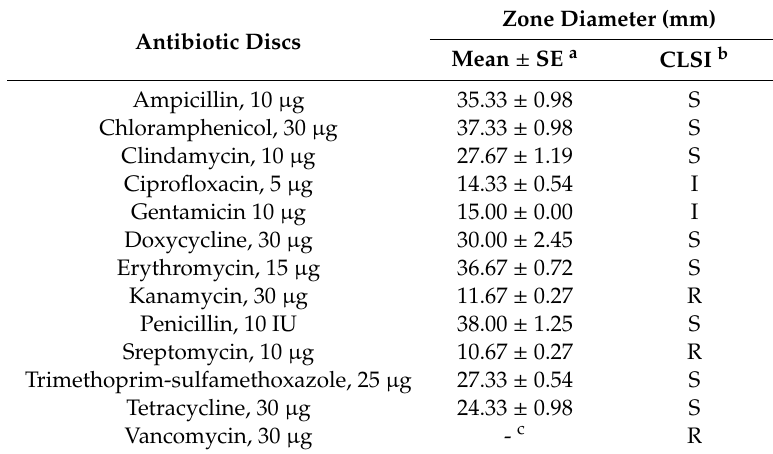
Table 2. Antibiotic susceptibility of LPLB5.